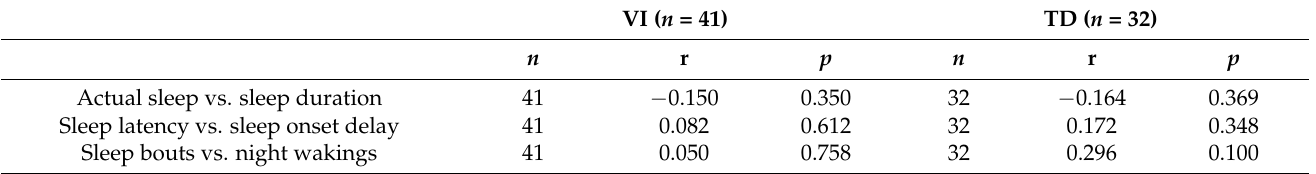
Table 5. Correlation between objective actigraphy measure parent-report CSHQ